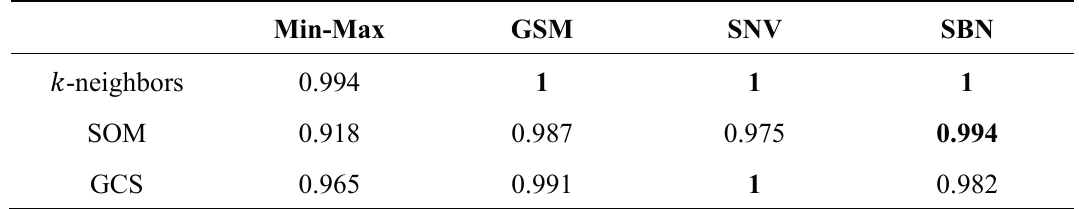
Table 5. Kappa indices obtained with the three classification techniques and the four normalization methods when denoising with the Savitzky-Golay method and (cid:1866) = 13 .